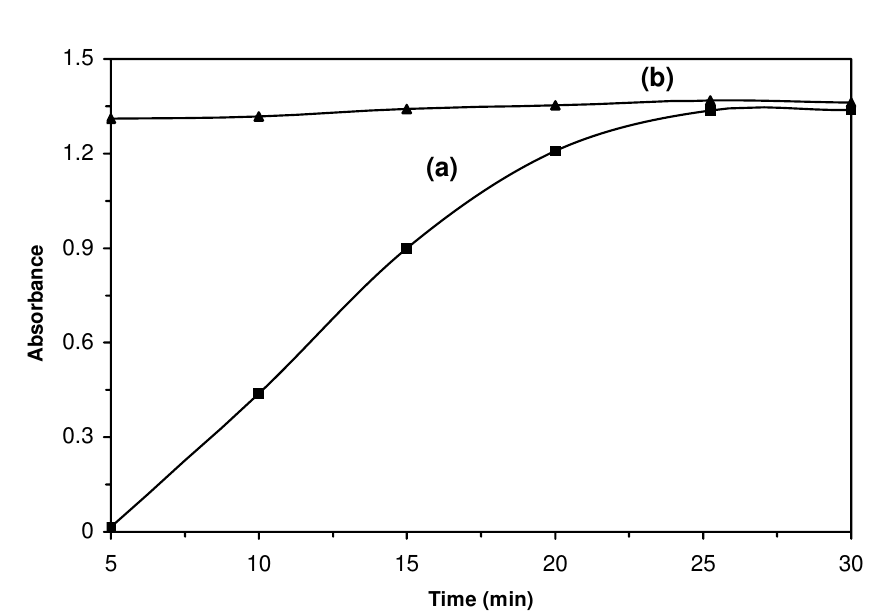
Fig. 1 Effect of heating time on the oxidation of: (a) gentamicin-MB and (b) vancomycin- AO.